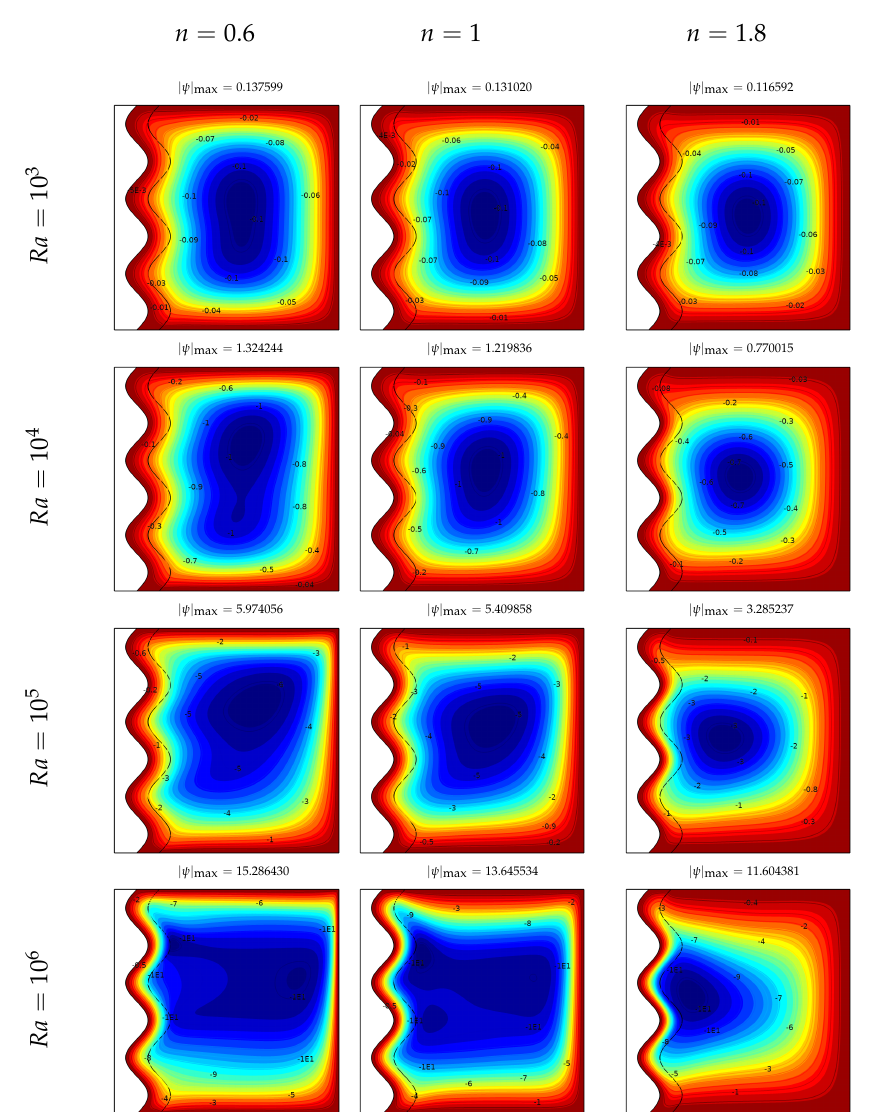
Figure 3. Streamlines for different values of power law indices n and Rayleigh numbers Ra